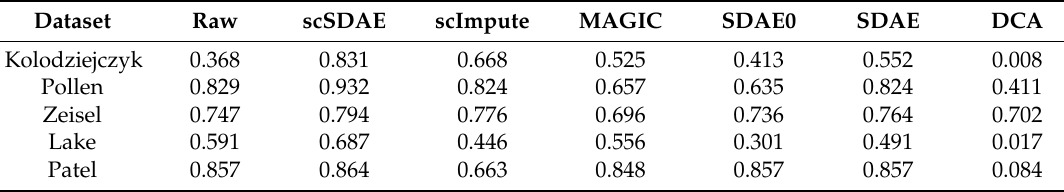
Table 2. ARIs of the clustering results of five datasets imputed by di ff erent methods. Dataset